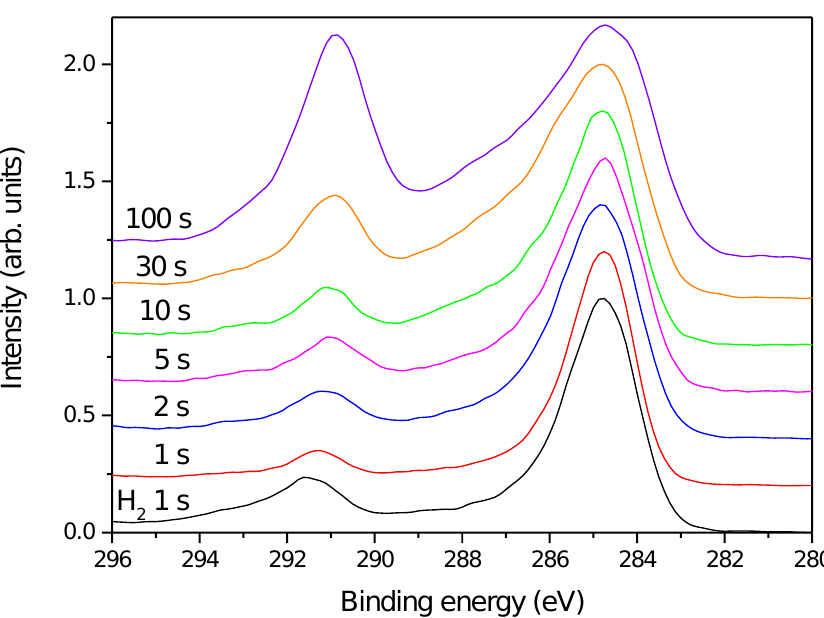
Figure 11. The high-resolution C1s spectra for samples treated at different times in ammonia plasma in the continuous mode at the power of 25 W.